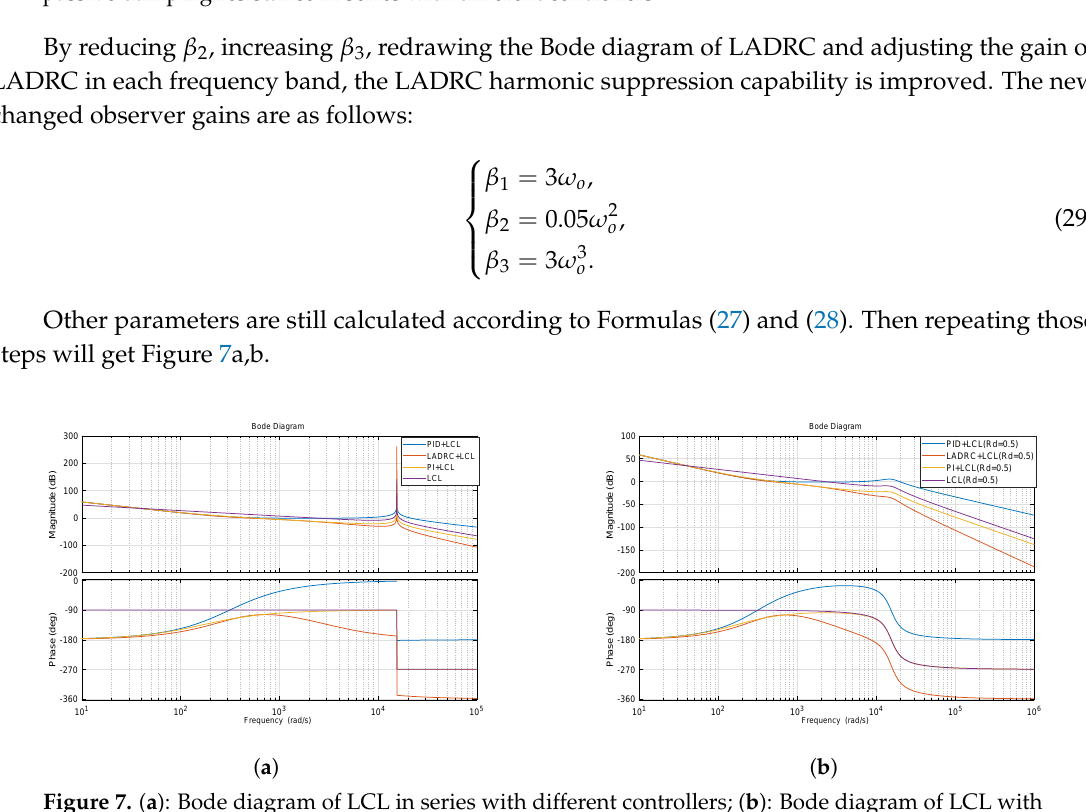
Figure 6. ( a ): Bode diagram of LCL in series with different controllers; ( b ): Bode diagram of LCL with passive damping resistance in series with different controllers.